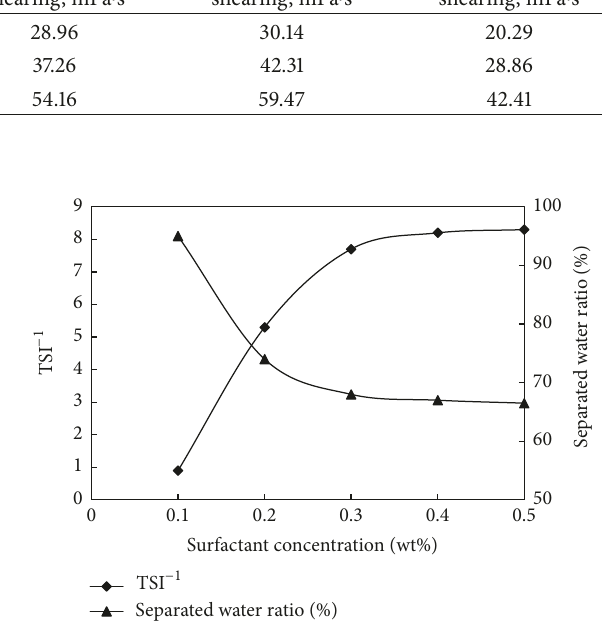
Figure 3: Minimum IFT between surfactant solution and oil with different surfactant concentrations.